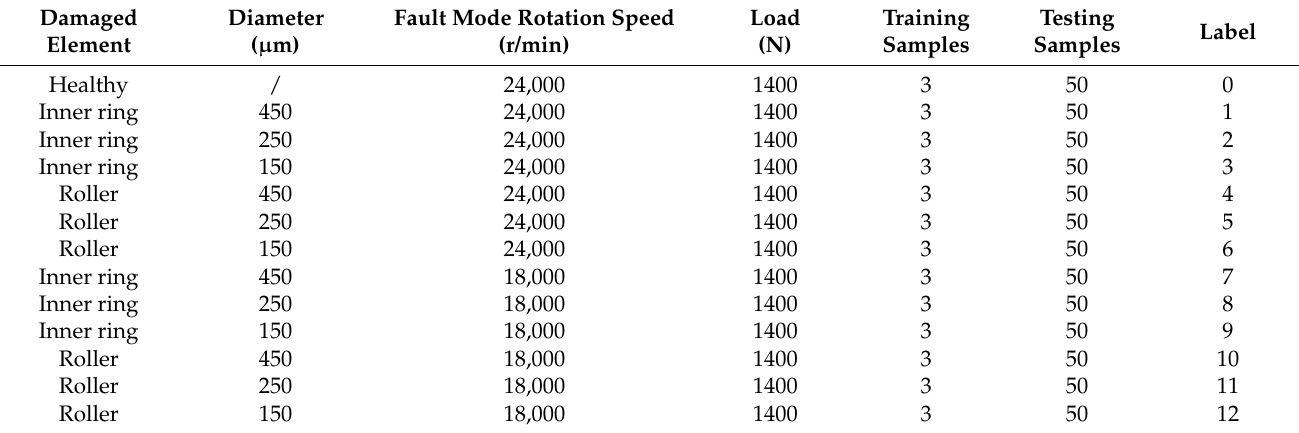
Figure 13. Test rig of the aero-engine bearing dataset from Polytechnic University of Turin. Table 6. Dataset 3: Aero-engine bearing dataset from Polytechnic University of Turin.